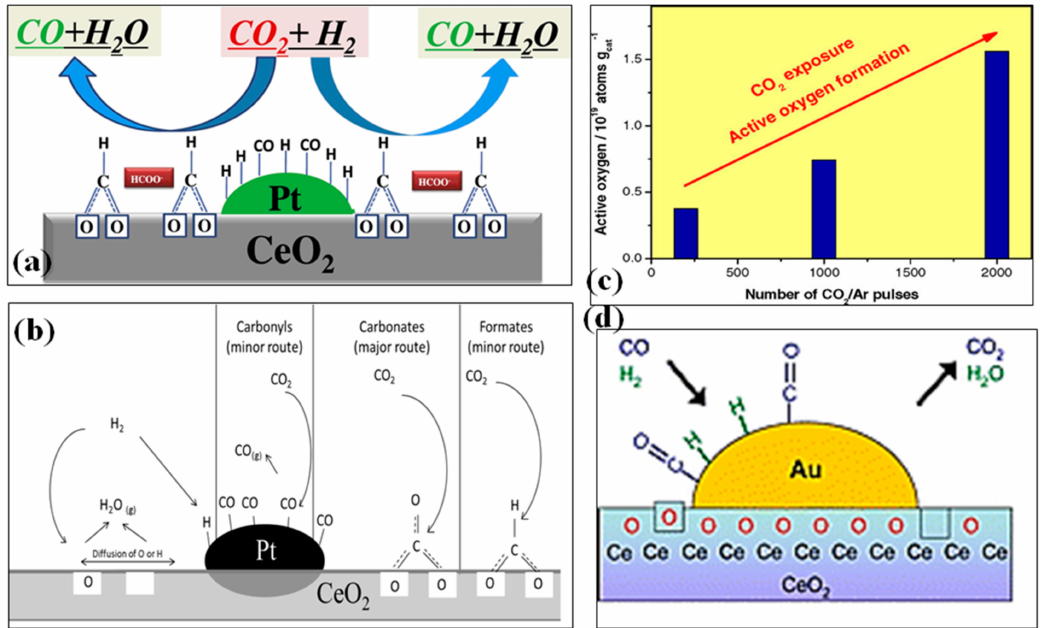
Figure 6. Model for the reaction mechanism of the RWGS reaction over ( a ) Pt − CeO 2 , reprinted with permission from [94]. Copyright Elsevier, 2016, ( b ) Pt − CeO 2 , reprinted with permission from [84]. Copyright Elsevier, 2004, ( c ) Au − CeO 2 , reprinted with permission from [80]. Elsevier, 2013, ( d ) Au − CeO 2 , reprinted with permission from [96]. Copyright Royal Society of Chemistry,